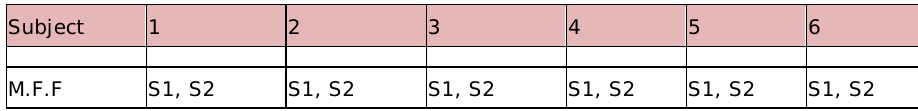
Table 2. “Layout of Pilot Study”. Source: Own